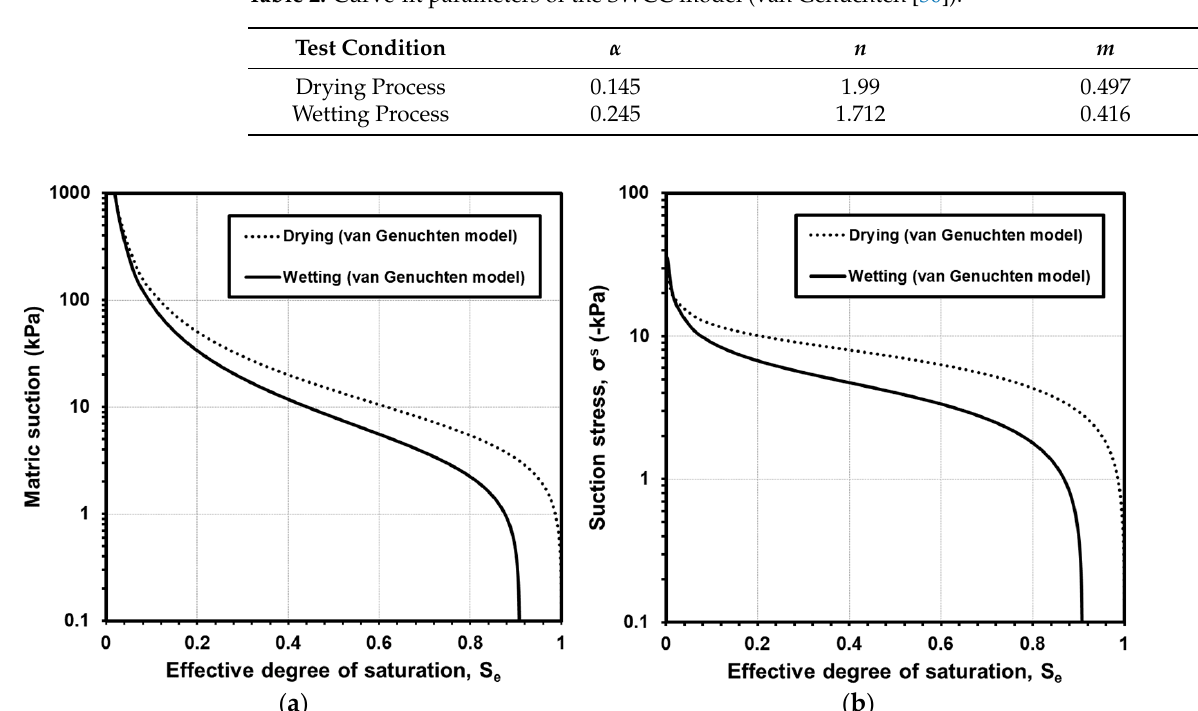
Figure 6. Unsaturated soil properties at the Songnisan landslide monitoring station: ( a ) soil–water characteristic curve and ( b ) suction stress characteristic curve.